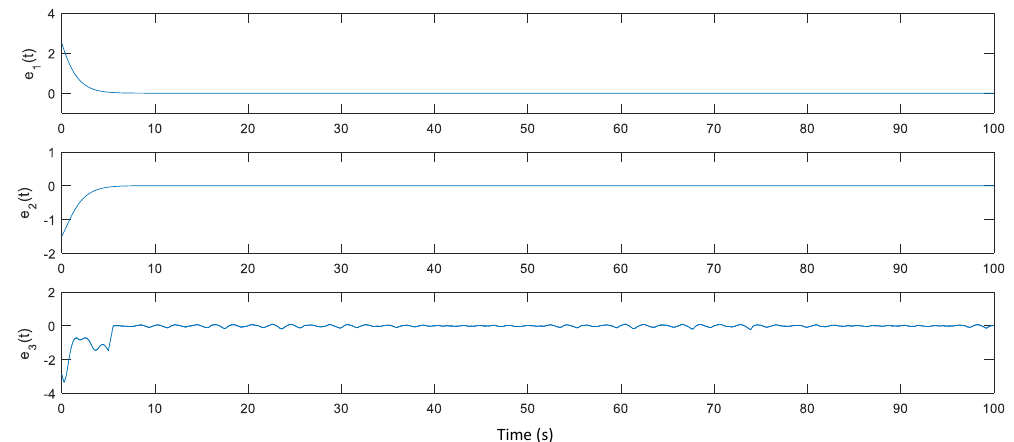
Figure 5. Synchronization error dynamics of unknown time-delay Jerk master slave chaotic systems (25), (26) using the proposed robust adaptive control strategy where it is activated at 𝑡 = 5 s .